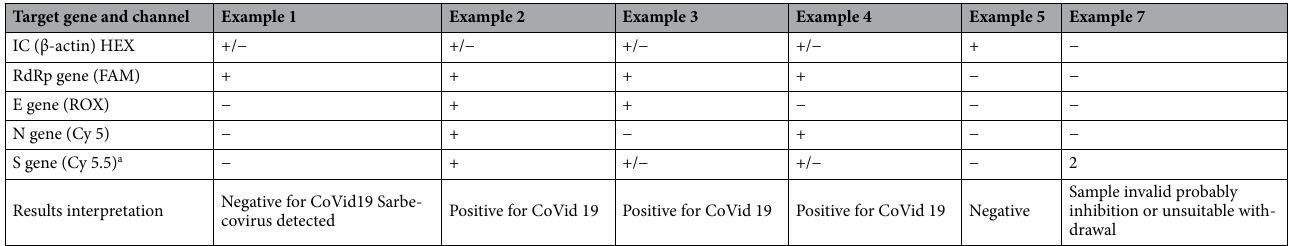
Table 4. Interpretation criteria used in our qRT-PCR assay. Cut off value for all gene is ≤ 40; In presence of strong signal of others genes, the signal of IC may be inhibited but the results still valid. In agreement with